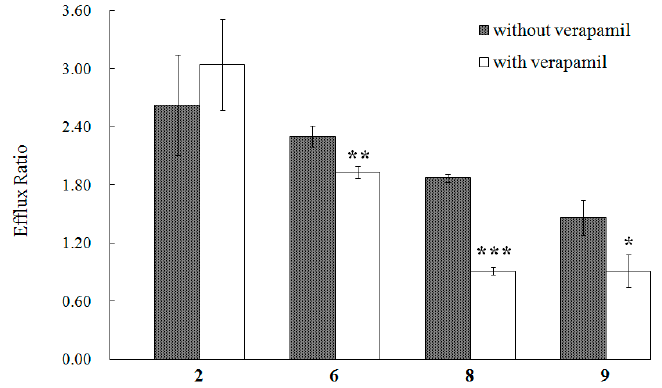
Figure 4. The efflux ratio of 2 , 6 , 8 and 9 in the MDCK-pHaMDR cell monolayer in the absence or presence of verapamil. Presented data are mean ± SD ( n = 3). * p < 0.05, ** p < 0.01, and *** p < 0.001.